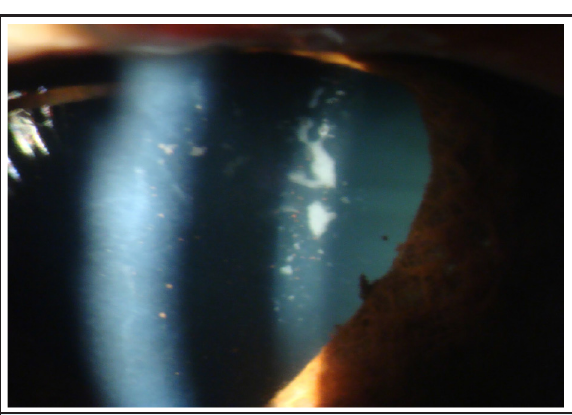
Figure 3. Glaucomflecken in right eye seen after cor - nea subsided.